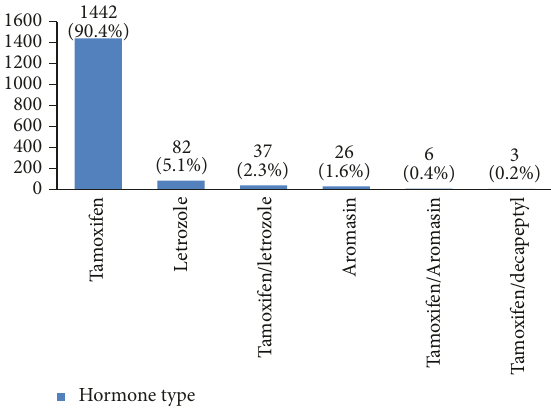
Figure 32: The hormone type of the studied